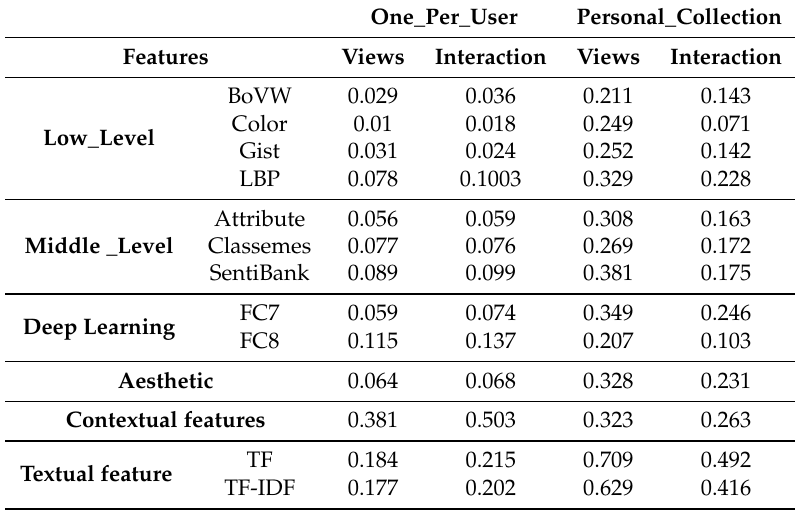
Table 9. Prediction results of SVR model using our features for one_per_user and Personal_collection settings.